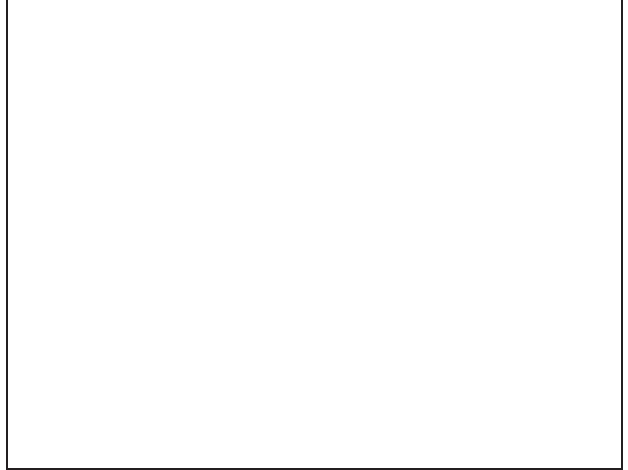
Fig. 3 : Sever NPDR (Double arrow - Venus Beading)